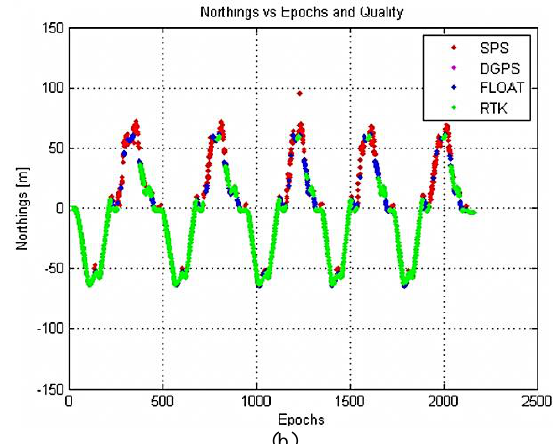
Figure 9. Mobile Kinematic Results: (a) Javad Easting Time Series; (b) Javad Northing Time Series.